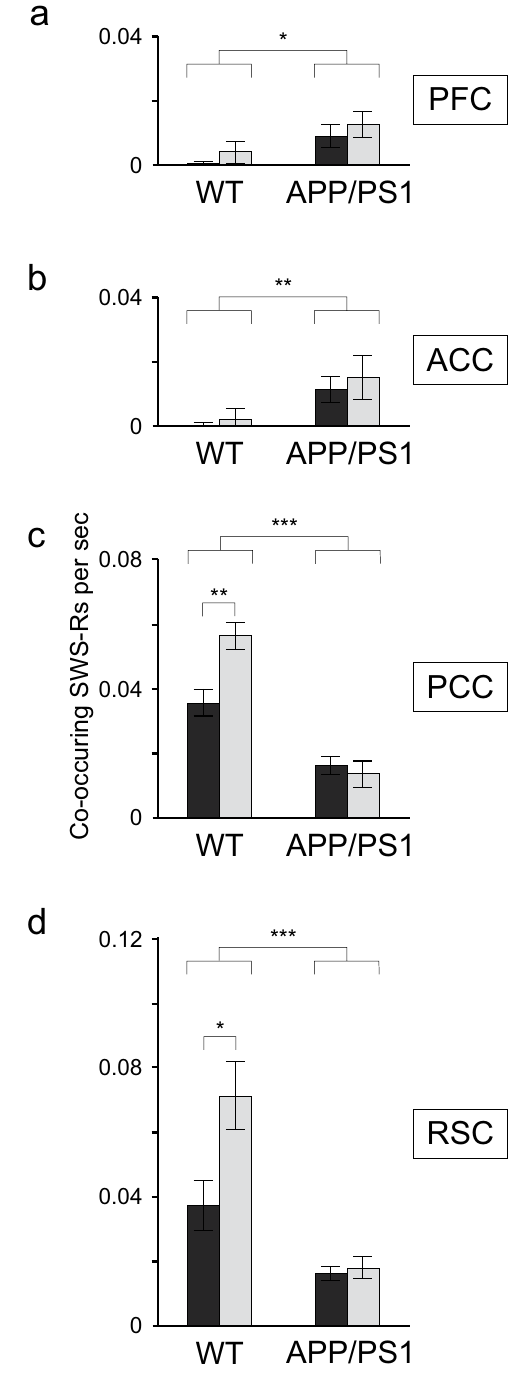
Figure 4. Co-occurrence of cortical and hippocampal ripples was altered in APP-PS1 mice. ( a,b) In the control animals the rate of PCF and ACC ripples co-occurring with hippocampal ripples was not different from zero (P > 0.2, Wilcoxon signed rank), whereas in APP-PS1 animals the rate was significantly higher (ACC: N = 7, P = 0.004, Friedman’s test, PFC: N = 7, P = 0.011, Friedman’s test) but not learning dependent (P > 0.5, Wilcoxon rank-sum) c,d . In the WT group, the rate of PCC and RSC ripples co-occurring with CA1 ripples was significantly higher than in the APP-PS1 animals (N = 7, chi-sq = 13.13, P = 0.003, Friedman’s test (PCC); N = 7, chi-sq = 11.79, P = 0.001, Friedman’s test (RSC)). Moreover and in contrast to the APP-PS1 group the rate increased after learning (WT: N = 7, P = 0.008, Wilcoxon rank-sum; APP/PS1: N = 7, P = 0.93, Wilcoxon rank-sum (PCC); WT: N = 7, P = 0.026, Wilcoxon rank-sum; APP/PS1: N = 6, P = 0.804, Wilcoxon rank-sum